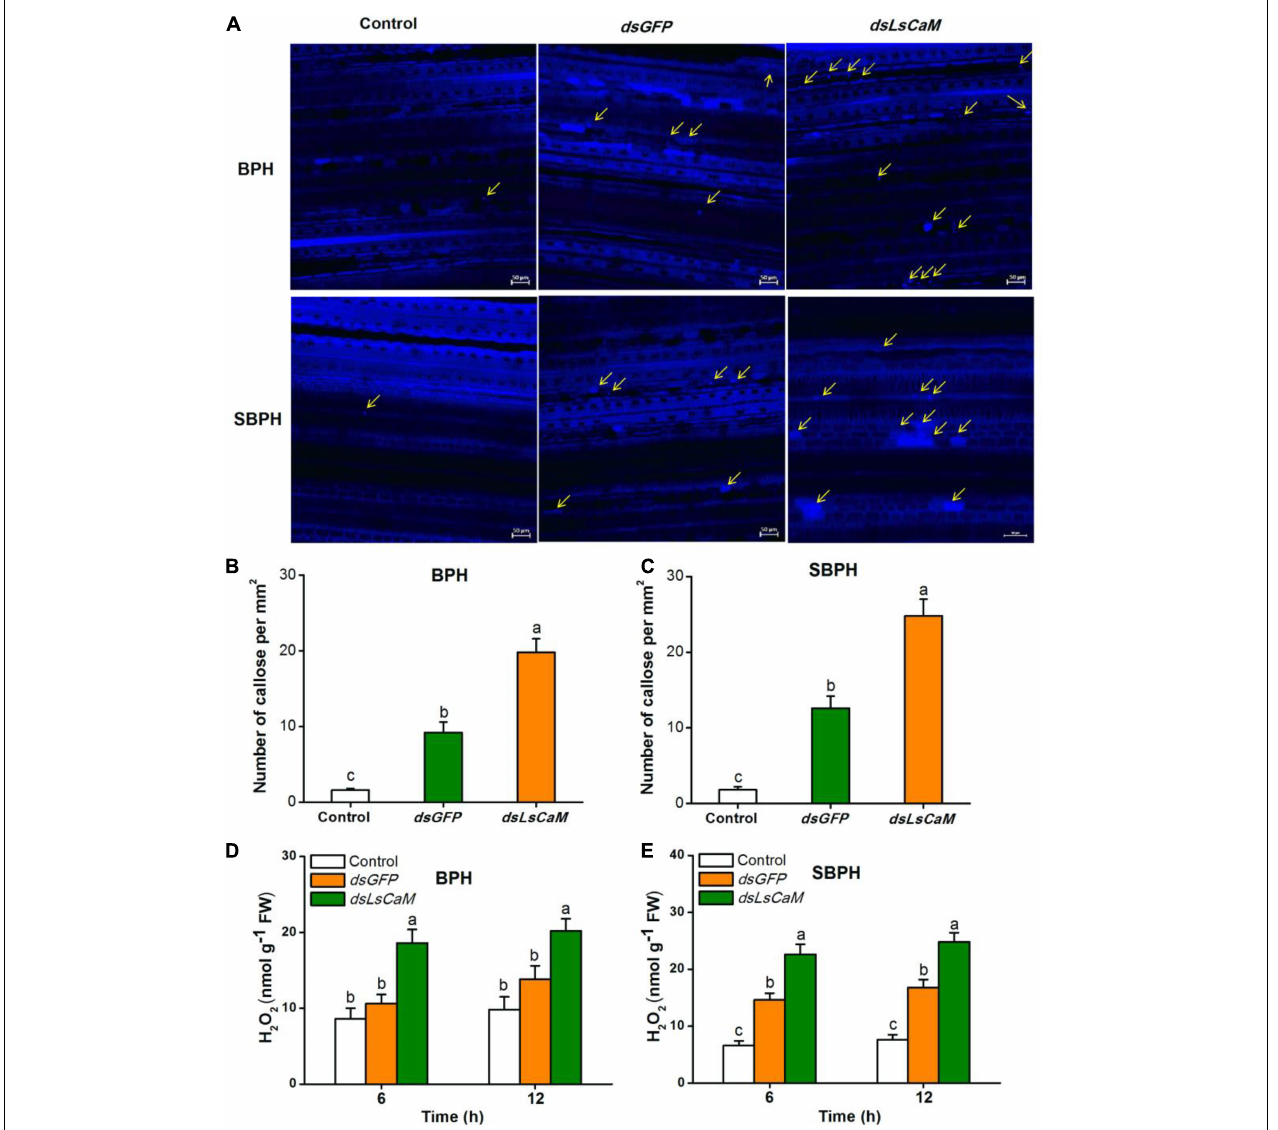
FIGURE 6 | Calmodulin secreted by BPH and SBPH suppresses callose deposition and H 2 O 2 accumulation in rice. (A) Representative images of callose deposition in rice leaves indicated by bright blue fluorescence. Rice leaves were infested for 12 h with 30 fifth-instar BPH or SBPH nymphs that were injected 2 days earlier with dsLsCaM or dsGFP . The uninfested rice leaves severed as controls. Yellow arrows indicate deposited callose. Bars = 50 µ m. (B,C) Mean number of callose deposits + SE ( n = 20) per mm 2 . Nymphs and rice leaves received same foregoing treatments. (D,E) Mean H 2 O 2 levels + SE ( n = 6) in rice plants receiving same foregoing treatments. Different lowercase letters indicate significant difference between treatments ( P ≤ 0.05; one-way ANOVA followed by Duncan’s multiple range